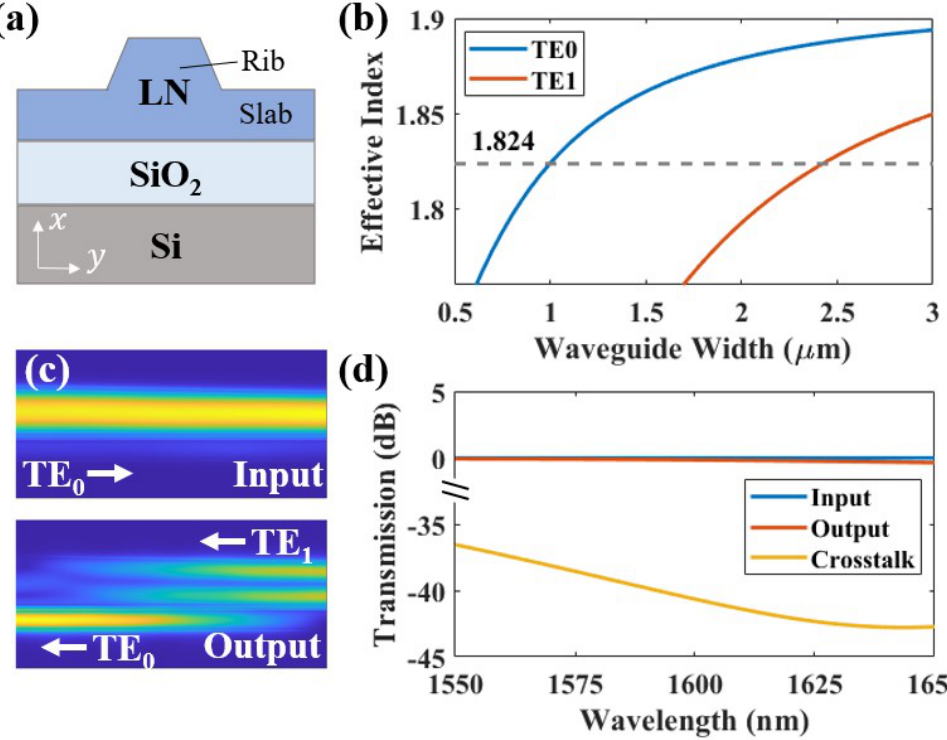
Figure 2. ( a ) Cross section of the TFLN waveguide. ( b ) Effective indexes of the TE 0 and TE 1 modes versus the waveguide width. ( c ) Light propagation of the ADC when TE 0 and TE 1 modes are injected. ( d ) The simulated ADC spectrum